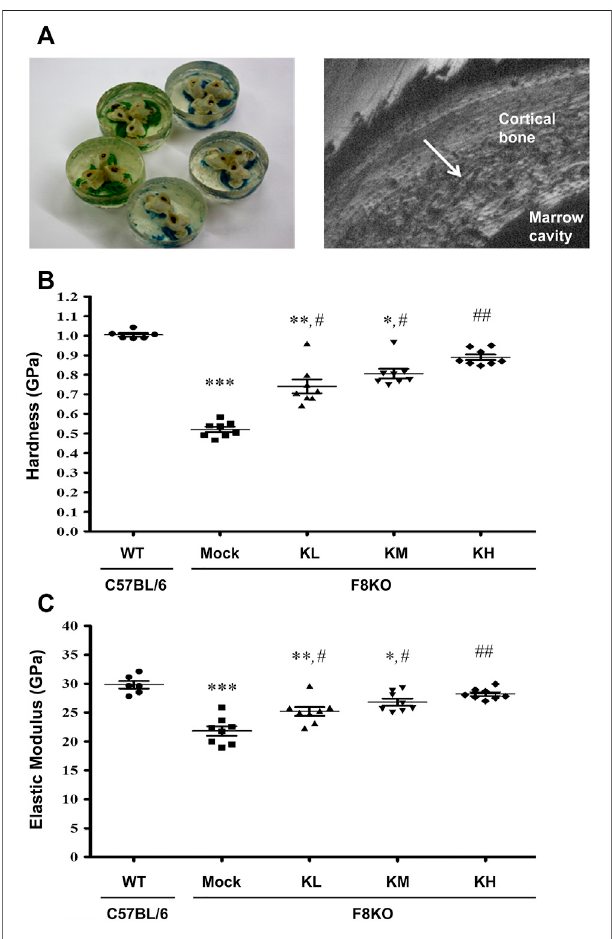
FIGURE 4 | Effects of KP treatment on the mechanical properties of femoral cortical bone. (A) Transverse-dissected distal femur bones were embedded in resin ( left ), and a diamond indenter was used to microindent the polished surfaces of the cortical bone from the outer side to the inner side for 10 points by nanoindentation, as shown in a scanning electronic microscopy image ( right ). The quantitative results exhibited the mechanical properties of (B) hardness and (C) elastic modulus. * p < 0.05, ** p < 0.01, and *** p < 0.001 vs. WT group; # p < 0.05, ## p < 0.01 vs. mock group.